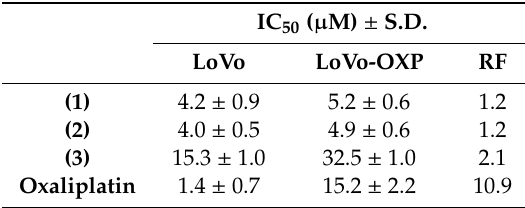
Table 3. Cross-resistance profiles.